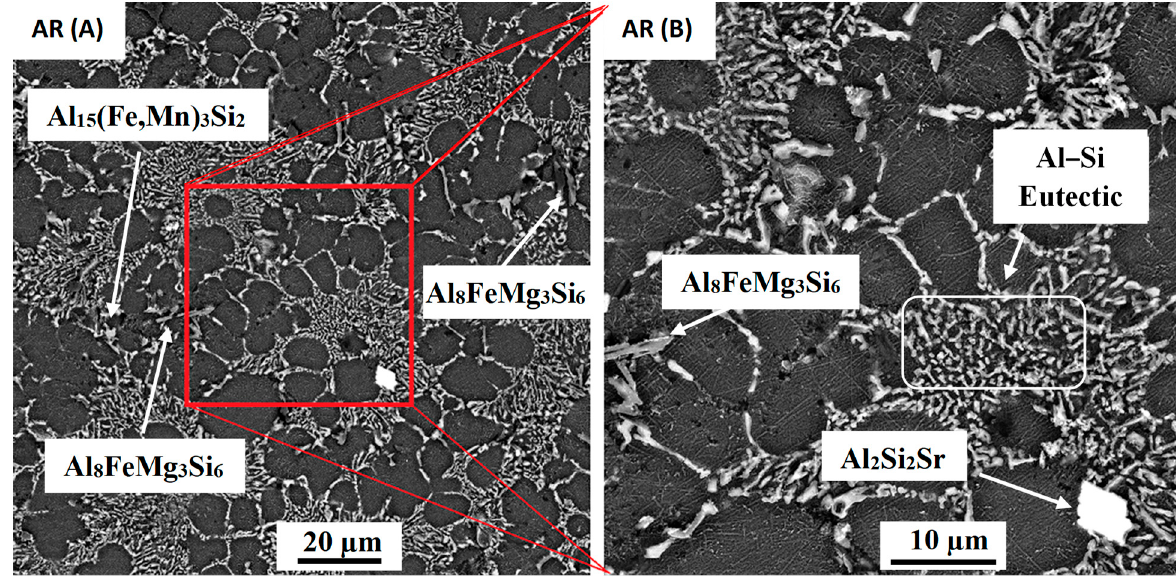
Figure 3. Representative micrographs for the as-cast component: ( A ) AR location; ( B ) close-up image of the red box region in ( A ) showing various phases.